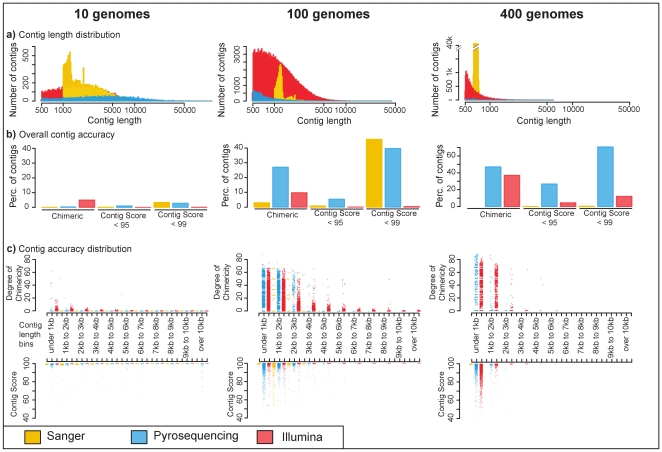
Comparison of assemblies from different sequencing technologies.a) Contig Length Distribution. Histograms of the contig lengths illustrate the number of contigs within a certain size fraction for assemblies of Illumina reads with quality filtering (red), Sanger sequenced reads (yellow) and reads from pyrosequencing (blue). Only contigs greater than 500 bp are shown, the x-axis is log scale. Assemblies were generated for different community complexities (10 genomes, 100 genomes, 400 genomes). b) Overall Accuracy of the Contigs. The overall accuracy of the contigs is summarized using different measures of chimericity. Bars to the left illustrate the percentage of all of the contigs that are chimeric, bars in the middle show the percentage of all of the contigs that have a Contig Score less than 95%, and to the right contigs that have a Contig Score less than 99%. Contig Score represents the percent identity between the contig and the derived reference genome. Contigs from Illumina reads are red, contigs from Sanger reads are yellow and contigs from pyrosequencing are blue. In general there was a slightly higher proportion of Illumina contigs that were chimeric, however they had higher contig scores. c) Contig Accuracy across Contig Lengths. These combined strip plots show the degree of chimericity (upper plot) and contig score (lower plot) for each contig in the assemblies, each dot represents one contig. They are grouped into size bins. The degree of chimericity is the proportion of reads in a contig that are derived from the ‘wrong’ genome and thus make the contig chimeric. Contig Score represents the percent identity between the contig and the derived reference genome. Again contigs from Illumina assemblies are in red, from Sanger assemblies are in yellow and from pyrosequencing assemblies are in blue. For all sequencing technologies and communities, longer contigs are more accurate.